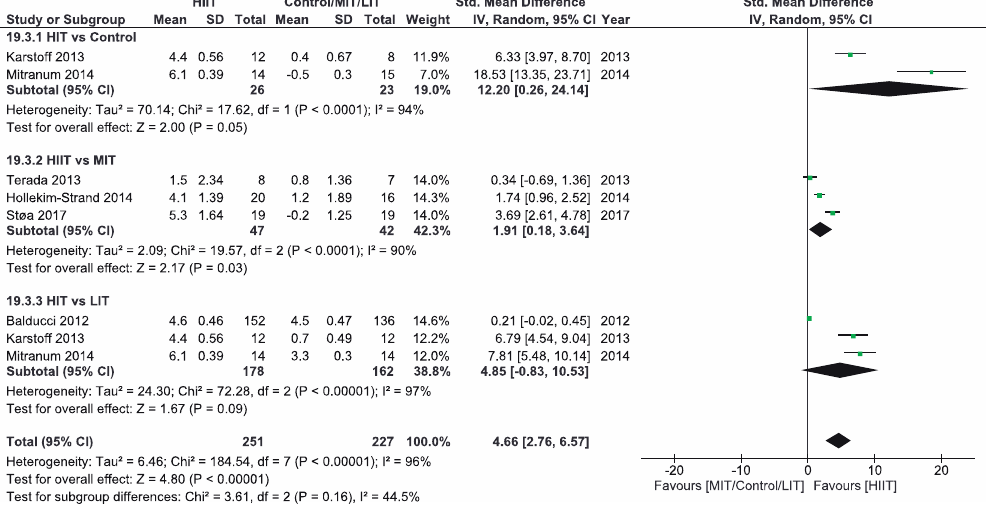
Figure 6. Forest plot for VO2max. HIIT—high-intensity interval training, MIT—moderate-intensity training, LIT—low-intensity training, CI—confidence interval, IV—inverse variance, SD—standard deviation.